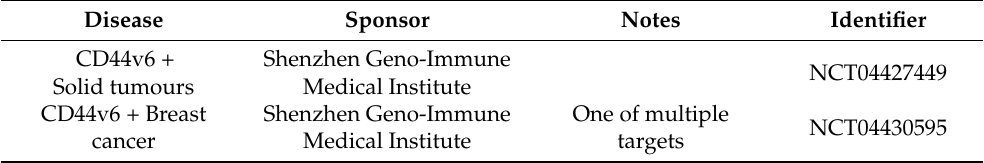
Table 4. Ongoing CAR T-cell clinical trials directed against CD44v6 (accessed on 10 January